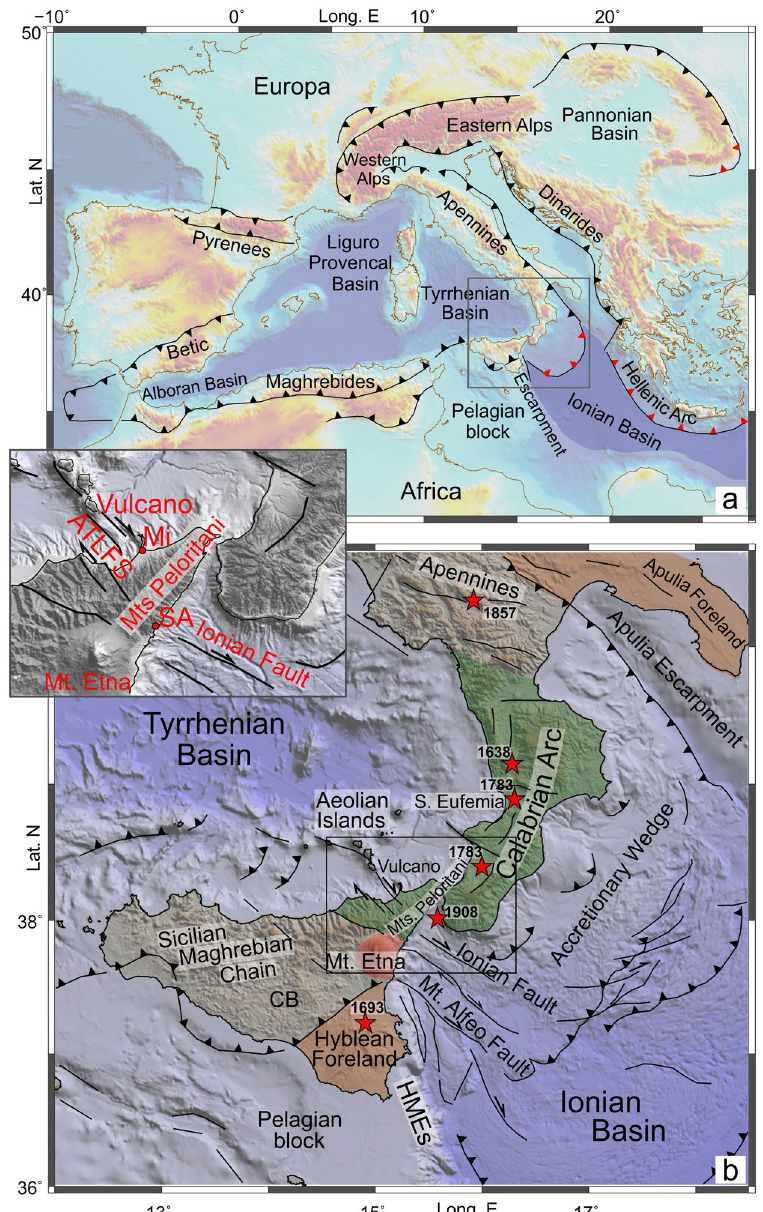
Figure 1. ( a ) Shaded-relief map of the Mediterranean realm showing the main orogenic belts, basins and subduction zones. Sawteeth point in the direction of subduction or underthrusting (in red where the subducting slab is considered to be continuous). ( b ) Main geological and tectonic features of the studied region (see text for references). Epicentres of the major earthquakes (M ≥ 7) of the last four centuries are shown as red stars (from https://emidius.mi.ingv.it/CPTI15-DBMI15/). Abbreviations are as follows: HMEs, Hyblean- Maltese Escarpment; CB, Caltanissetta Basin; ATLFS, Aeolian-Tindari-Letojanni Fault System; Mi, Milazzo; SA, Capo S. Alessio. Topography is from ref. 46 . The maps were created using QGIS (version 10.2.1; http://qgis.org) and Generic Mapping Tools (GMT version 4.5.6; http://gmt.soest.hawaii.edu). The figure was edited using Corel Draw Graphics Suite (version X5;